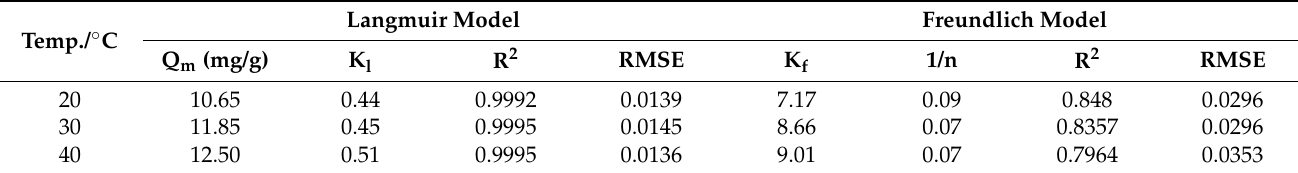
Figure 10. Cd adsorption isotherm model fitting: ( a ) Langmuir model; ( b ) Freundlich model. Table 4. Pb ion adsorption isotherm model fitting parameters.